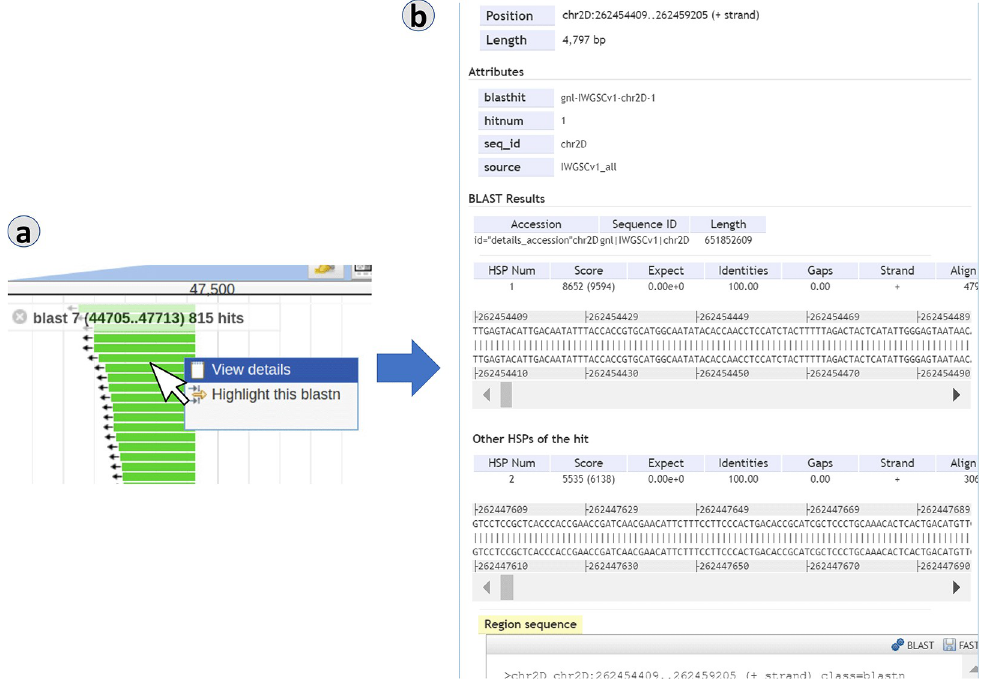
Fig 3. Details of a BLAST hit appear in a feature popup and include location, alignment, and external database links. Panels: (a) BLAST hit features, (b) BLAST hit